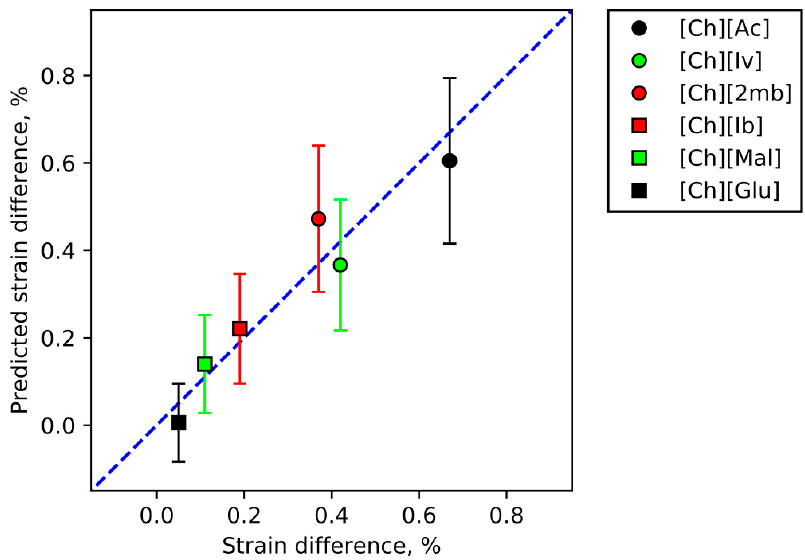
Figure 7. The measured strain differences of PPy-PVdF actuators vs the strain differences predicted by the cation-cation correlation peak height. Error bars correspond to ± 1 standard error. R 2 0.920, slope 34.465, intercept—0.089.